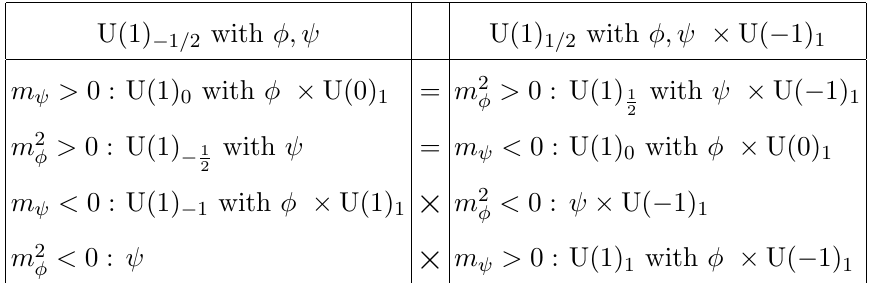
with φ, ψ U( 1) 1 . Phase diagrams. The two / 2 × −